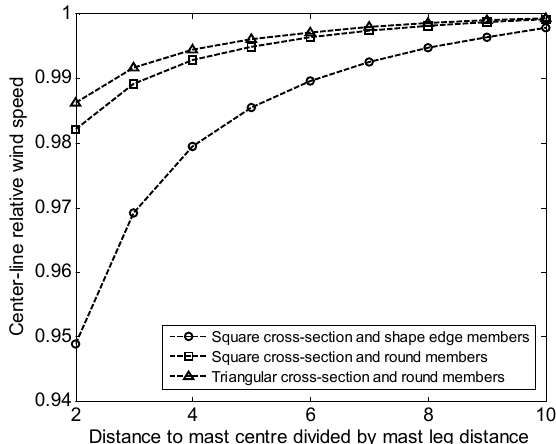
Figure 2. Center-line relative wind speed of lattice mast with average C T